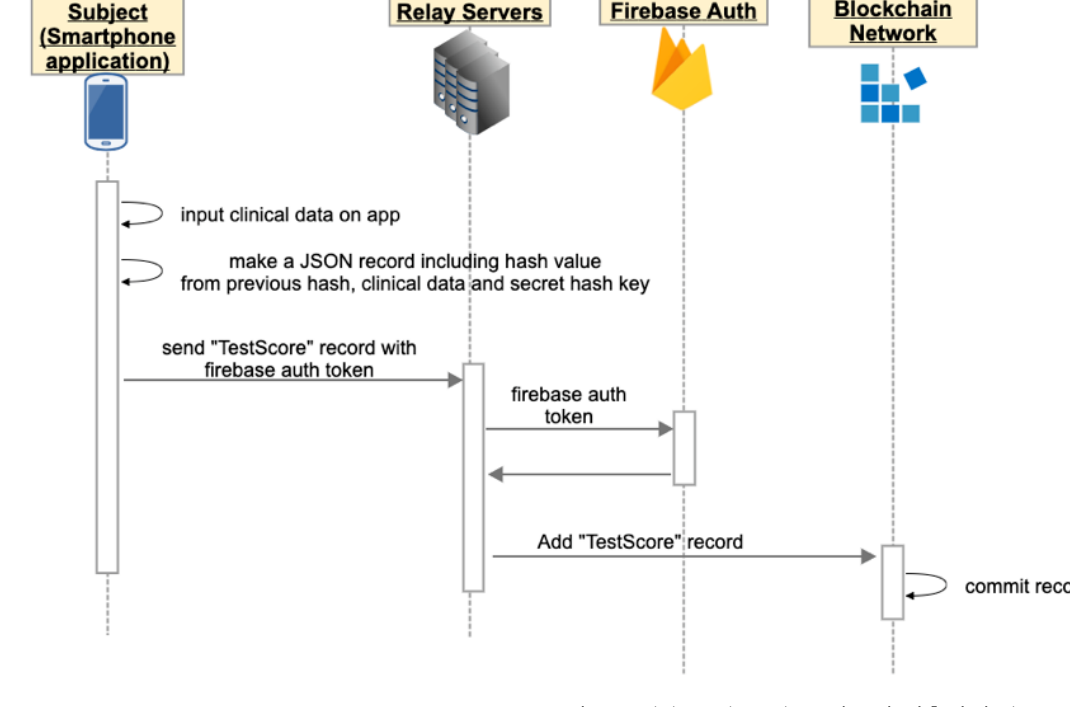
Figure 3. During the clinical trial, participant inputs clinical data using the mobile app. The app calculates the hash value based on the clinical data, the secret hash key preserved in the smartphone until the end of the study, and the previous hash value. The app sends the clinical data and a hash value to the blockchain network via relay servers.